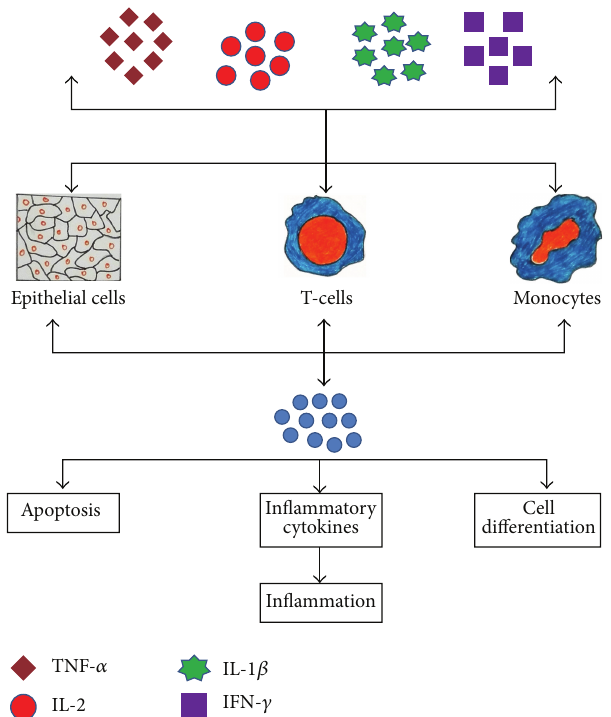
Figure 1: Mechanism of synthesis of IL-32 by different body cells (T-cells, epithelial cells, and blood monocytes) induced by various cytokines. IL-32 after its secretion affects a number of biological activities, namely, apoptosis and cell differentiation as well as mediation of inflammation.